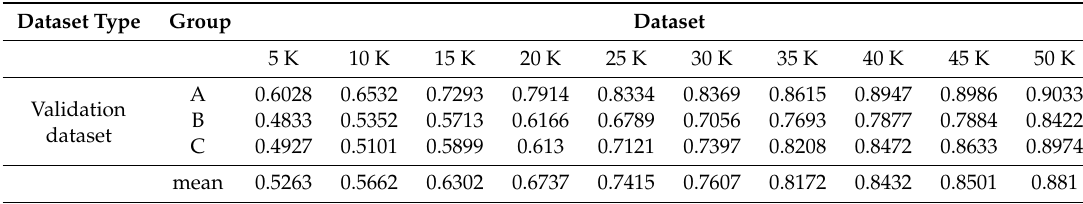
Table 2. Overall accuracy for each dataset.